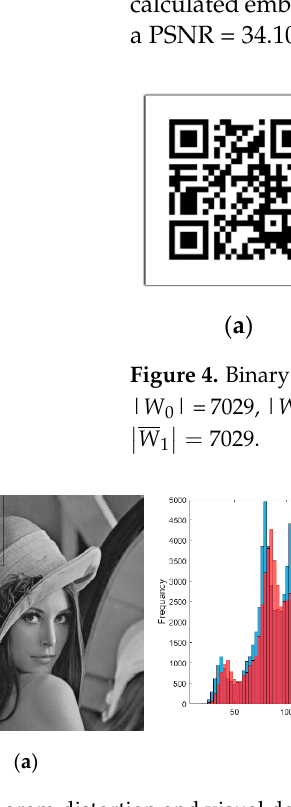
Figure 4. Binary watermark pattern of 150 × 150 size, | W | = 22,500. ( a ) Original watermark W ; with | W 0 | = 7029, | W 1 | = 15,471, ( b ) corresponding watermark complement W of ( a ); with